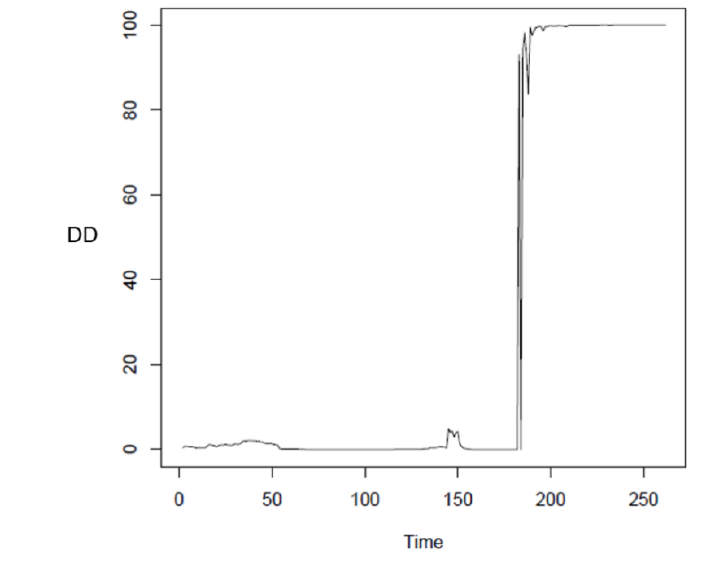
Fig. 3 The EDF function representing the company’s default distance. DD, distance to default; EDF, expected default